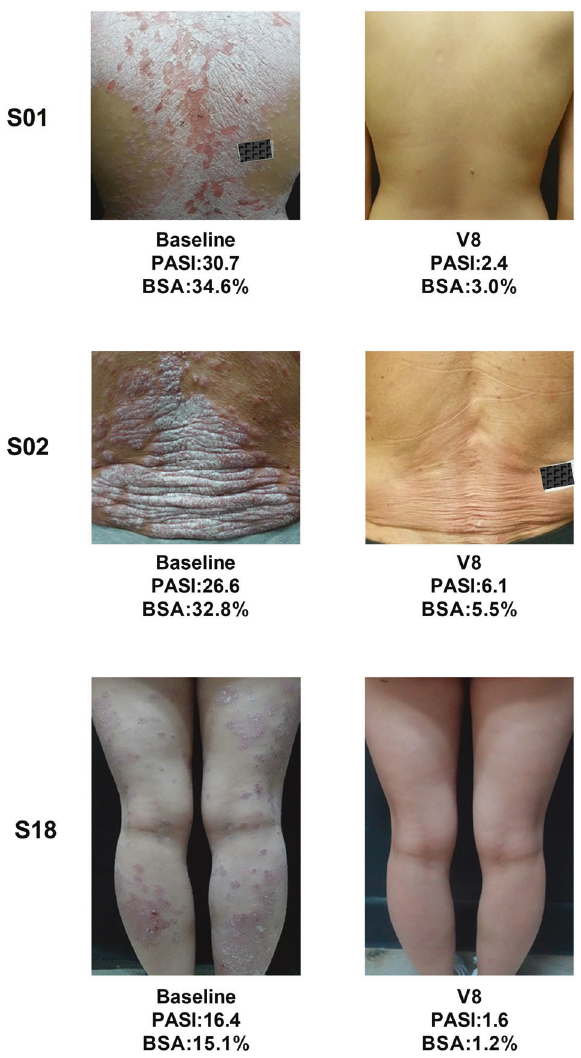
Fig. 3 Representative skin images of 3 patients before and after treatment